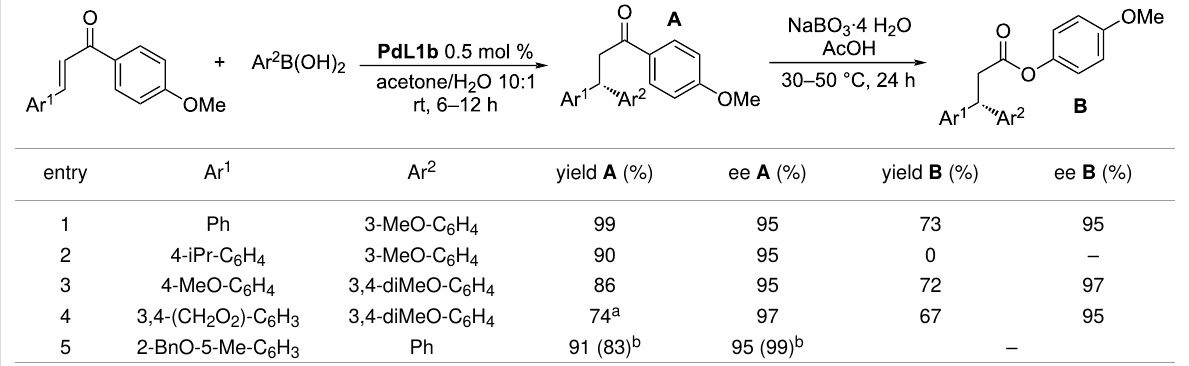
Table 5: Stepwise addition of arylboronic acids to electron-rich chalcones and Bayer–Villiger oxidation